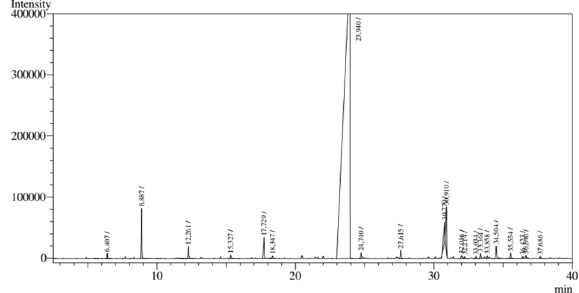
Figure 2: GC-MS chromatogram analysis C. cassia essential oil stems